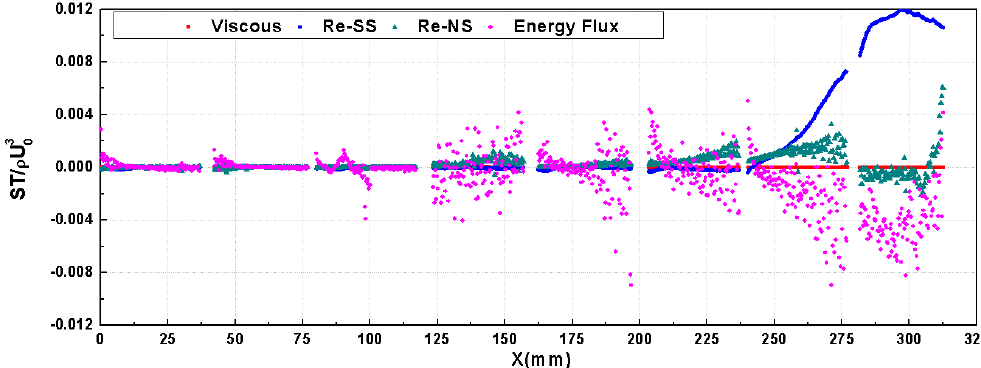
Figure 12. Streamwise variation of integral entropy generation.